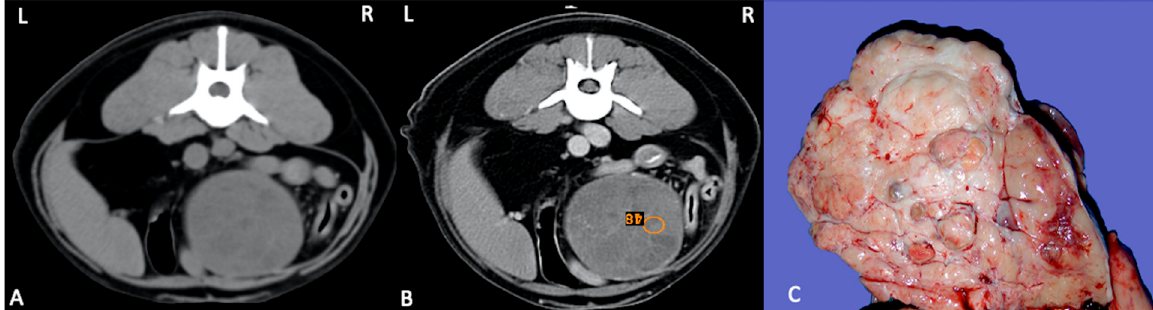
Figure 4. Pre ( A ) and postcontrast ( B ) CT study in dorsal recumbency of a 9-year-old, male entire English Setter with a large well capsulated mass in the mid abdomen with peripheral enhancement and several septae. ( B ) ROI is placed in the mass, and a mild contrast enhancement is visible. Final diagnosis: right testicular cryptorchid Sertoli cell tumour. ( C ) Gross appearance of the cryptorchid Sertoli cell tumour.